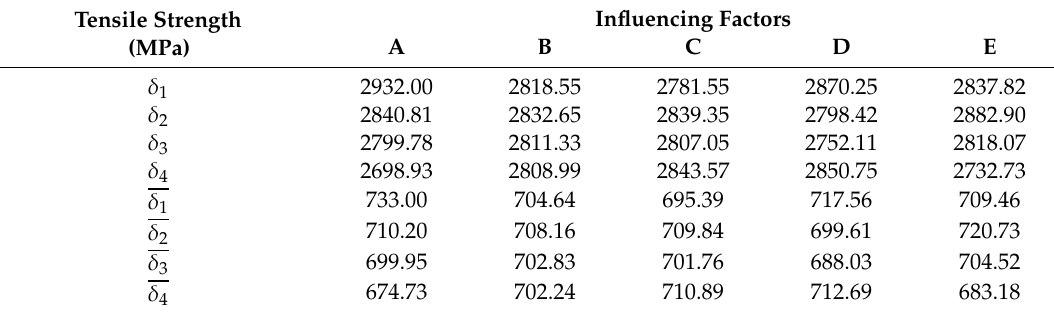
Table 5. The results on tensile strengths of the orthogonal tests.